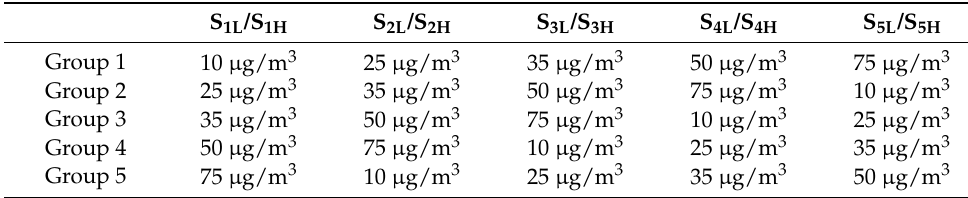
Table 4. Latin-square design for the